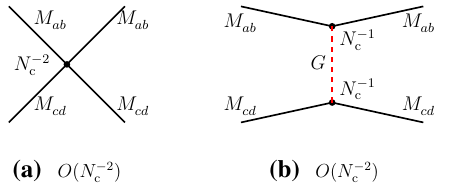
Fig. 4 a Four-meson vertex in the direct channel I of Eq. (2.3); b glueball exchange in the same channel. Similar diagrams also exist in the direct channel II